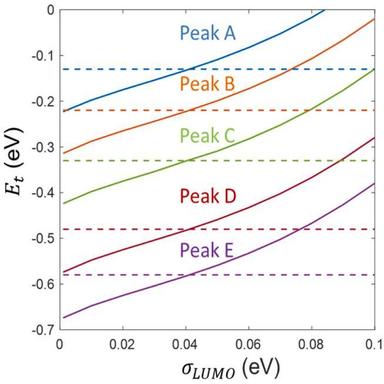
Comparison between the activation energies extracted from Ref. using the classical SRH method and the average activation energies extracted with our model at 300 K for different Gaussian widths.